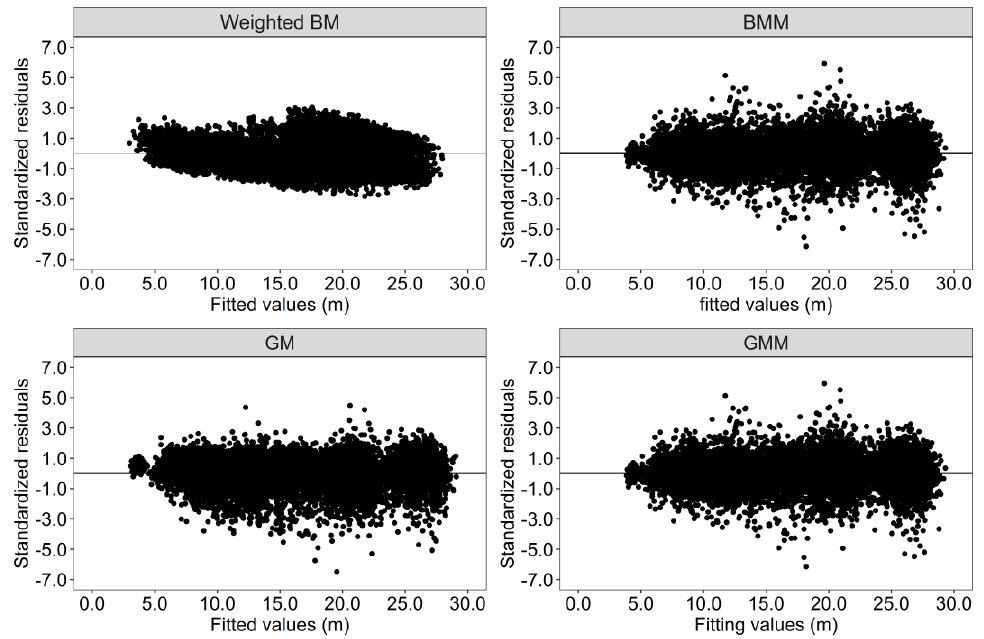
Figure 2. Standardized residual plot of the BM, BMM, GM, and GMM. Table 2. Parameter estimates (standard error) for the basic model (BM), basic mixed effects model (BMM) and basic quantile regression (BQR) model at nine quantiles (τ).